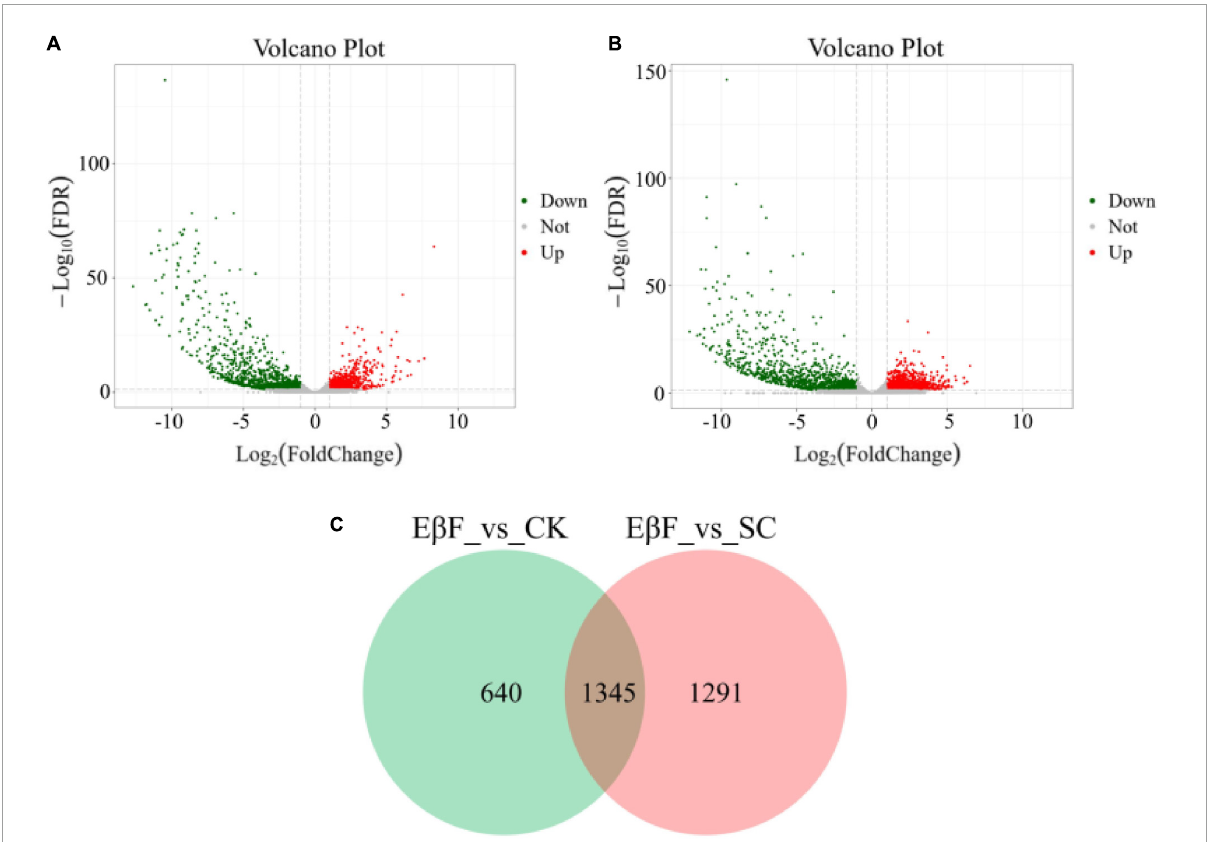
FIGURE1 The mixed graphs showed the relative expression level of all differentially expressed unigenes in S. exigua larvae after E β F treatments at doses of 4 g/kg. (A) The volcano plot obtained from the DESeq2 analysis between 4 g/kg E β F treatments and CK (blank control) samples showing log 2 (fold-change) and-Log 10 FDR values. (B) The volcano plot obtained from DESeq2 analysis between 4 g/kg E β F treatments and SC (solvent control) samples showing log 2 (foldchange) and-Log 10 FDR values. (C) The numbers of DEGs among different treatments among CK, SC, and 4 g/kg E β F treatment. The concentrations of E β F treatments were set as 4 g/kg; the unit of E β F treatment as g/kg means the mass ratio of E β F/artificial diet. The value denotes the value of log 2 (FPKM +